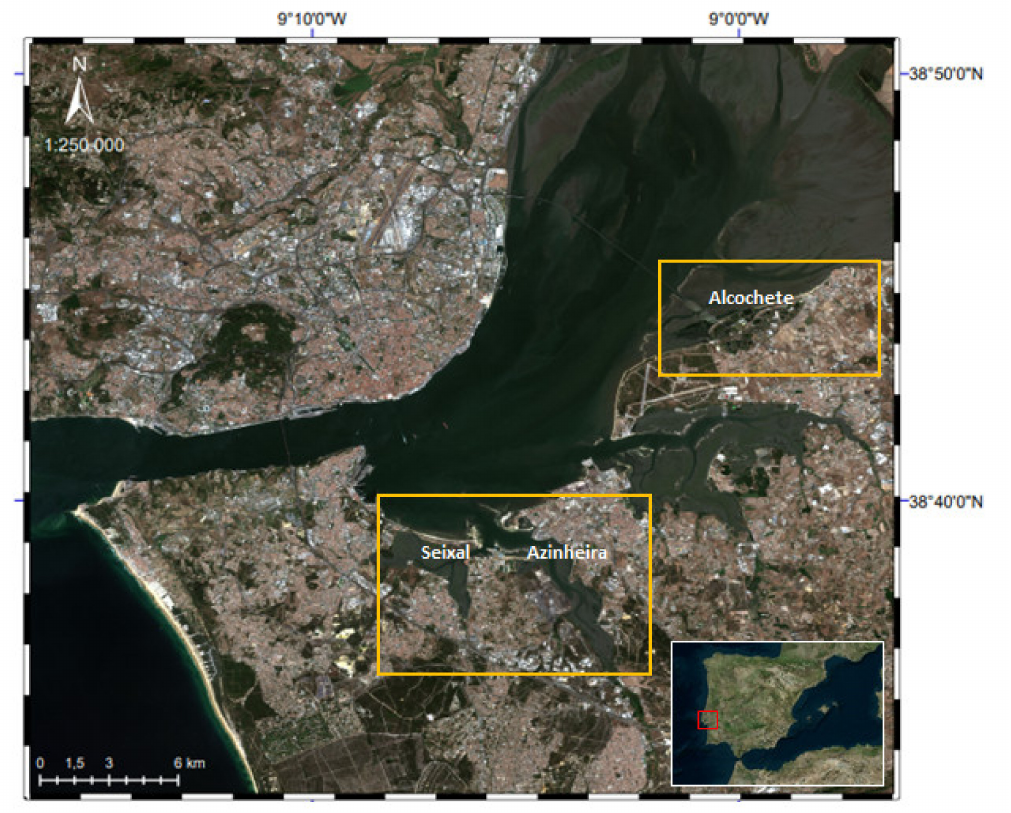
Figure 1. Tagus estuary in Lisbon. Red-green-blue (RGB) composite after atmospheric correction of Sentinel-2B imagery on 13 August 2018. The two orange rectangles identify specific intertidal areas at the Tagus estuary (top right—Alcochete and lower left—Seixal and